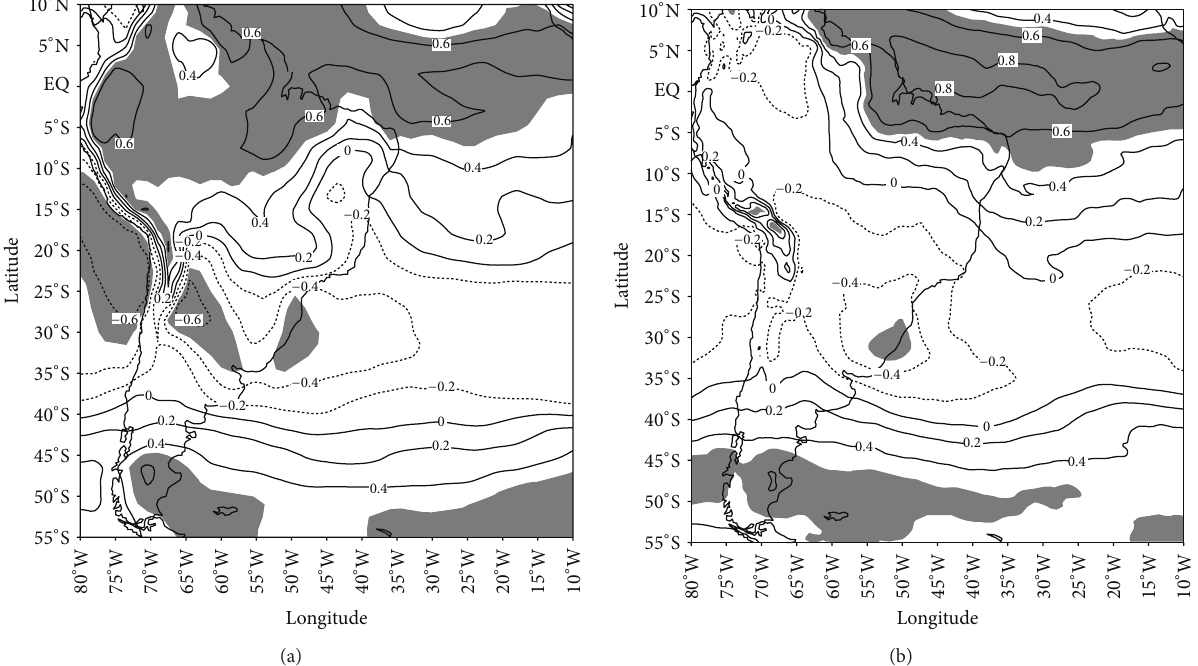
Figure 10: Correlation between the HCSA annual intensity index and the annual mean temperature (K) at 850 hPa in the period 1996– 2011 based on the (a) Era-Interim reanalysis and (b) RegCM4 simulation. Contour intervals are 0.2 and values above 0.5 are shaded and are statistically significant at 95% confidence level. For clarity purposes, it should be noted that the HCSA annual intensity index has been multiplied by ( −